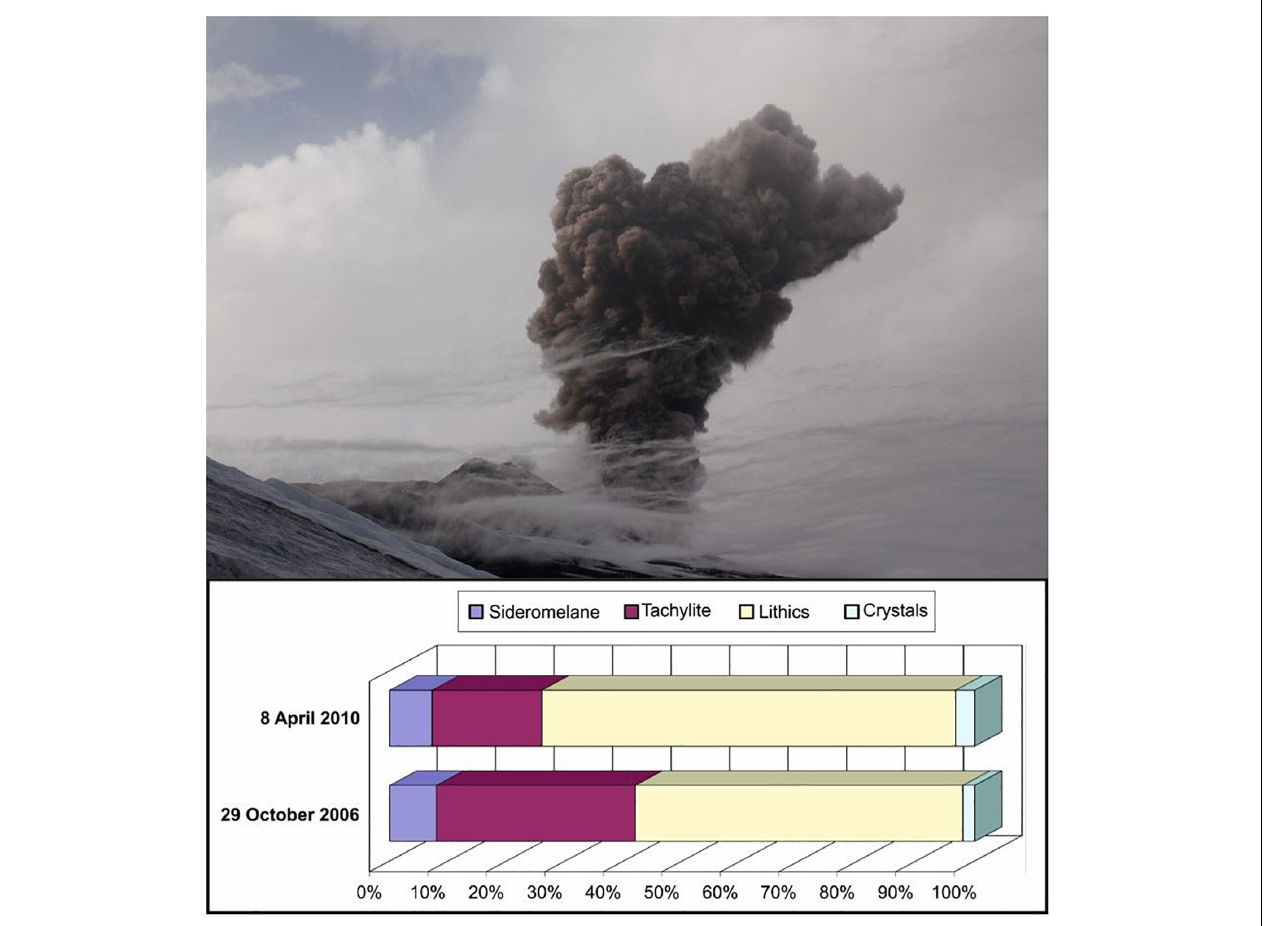
FIGURE 5 | Image of the peak in activity of the 8 April 2010 explosion and comparison between the ash componentry of the 29 October 2006 explosion and the average value of 4 samples collected at increasing distance from the vent after the 8 April 2010 explosion (data Andronico et al., 2013). Photo from Thomas Bretscher at https://www.flickr.com/photos/bretscher/4508419186/in/album-72157623824783982/. Reproduced with